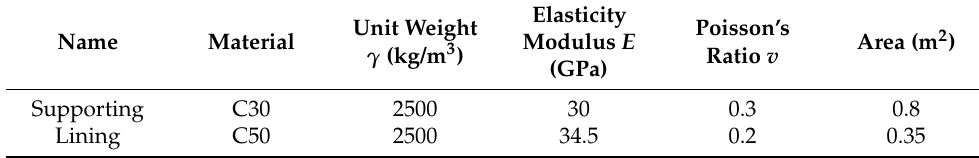
Table 2. The parameters of solid